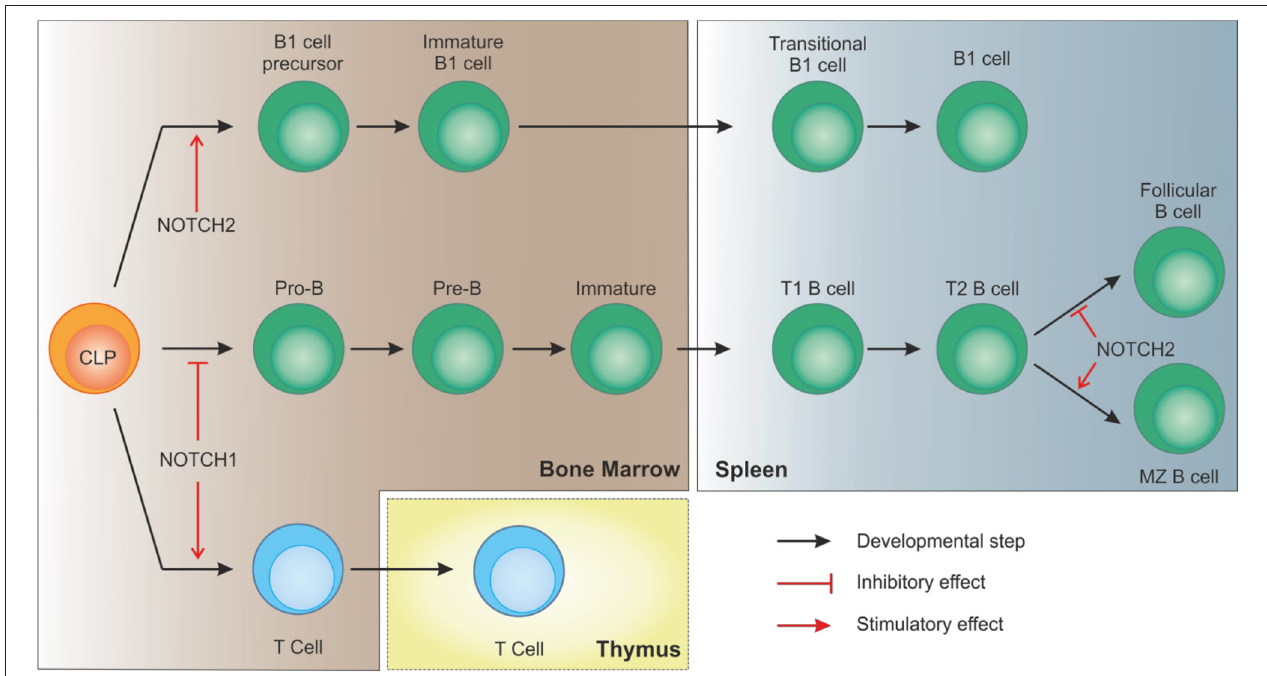
FIGURE 3 | NOTCH signaling in B cell development. In bone marrow-residing CLPs, NOTCH1 signaling must be switched off to allow proper B cell development. On the contrary, after migration of immature B cells to the spleen, interaction of DLL1 with NOTCH2, with the involvement of recombinant signal binding protein for immunoglobulin kJ region (RBPJk), induces NOTCH signaling in transitional B (T2) cells to specify marginal zone B cells, as opposed to follicular B cells. NOTCH2 signaling is also necessary for CLPs to differentiate toward B1